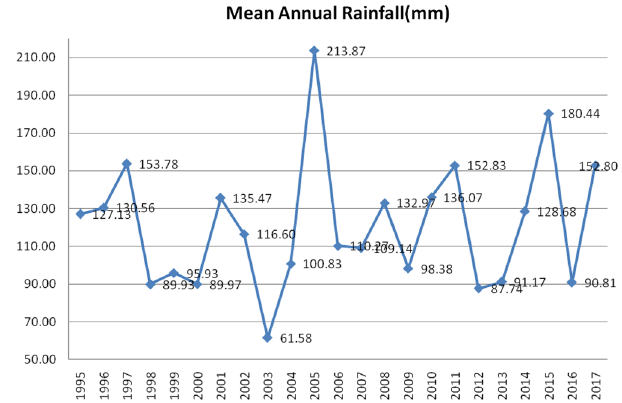
Figure 3. Yearly average rainfall in the study area (1995–2017).